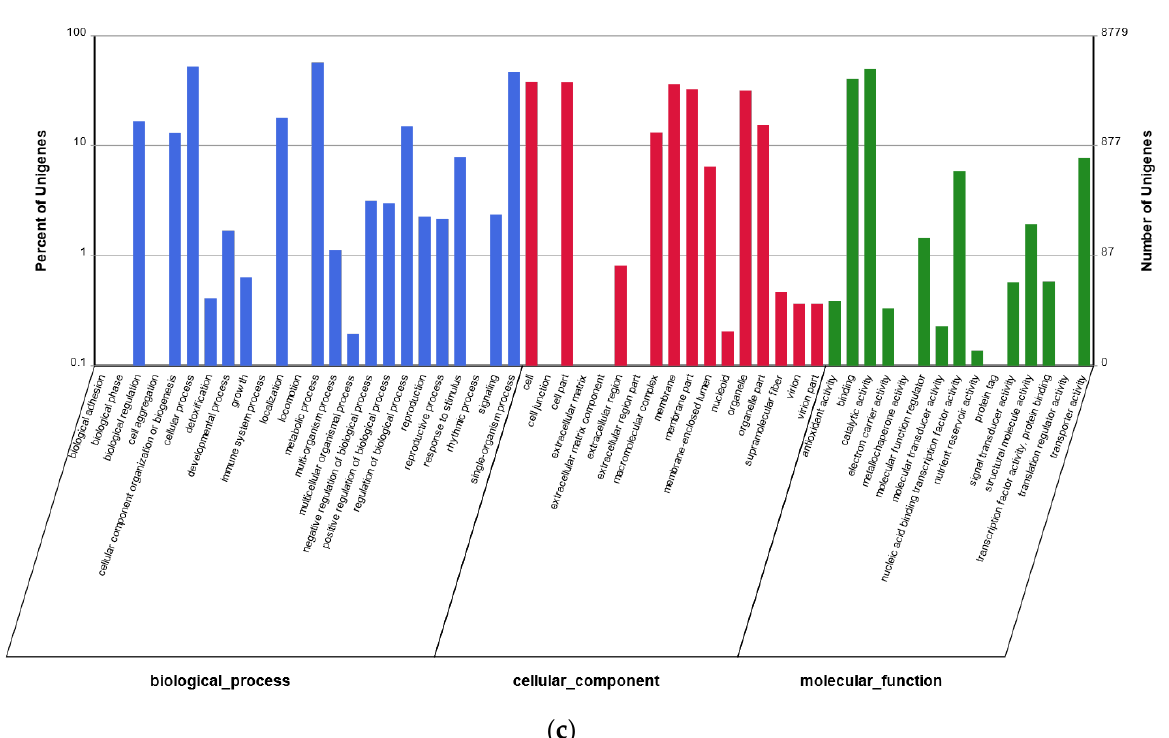
Figure 3. Functional annotation of strain R1 genes encoding the proteins: ( a ) Orthologous Groups of proteins (COG) analysis; ( b ) Kyoto Encyclopedia of Genes and Genomes (KEGG) analysis; ( c ) Gene Ontology (GO) analysis.